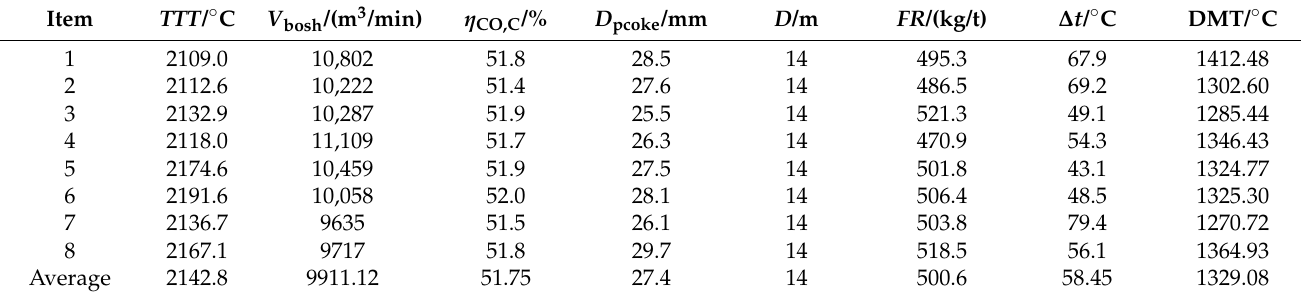
Table 3. Coke quality parameters and operation parameters of the 4350 m 3 BF in